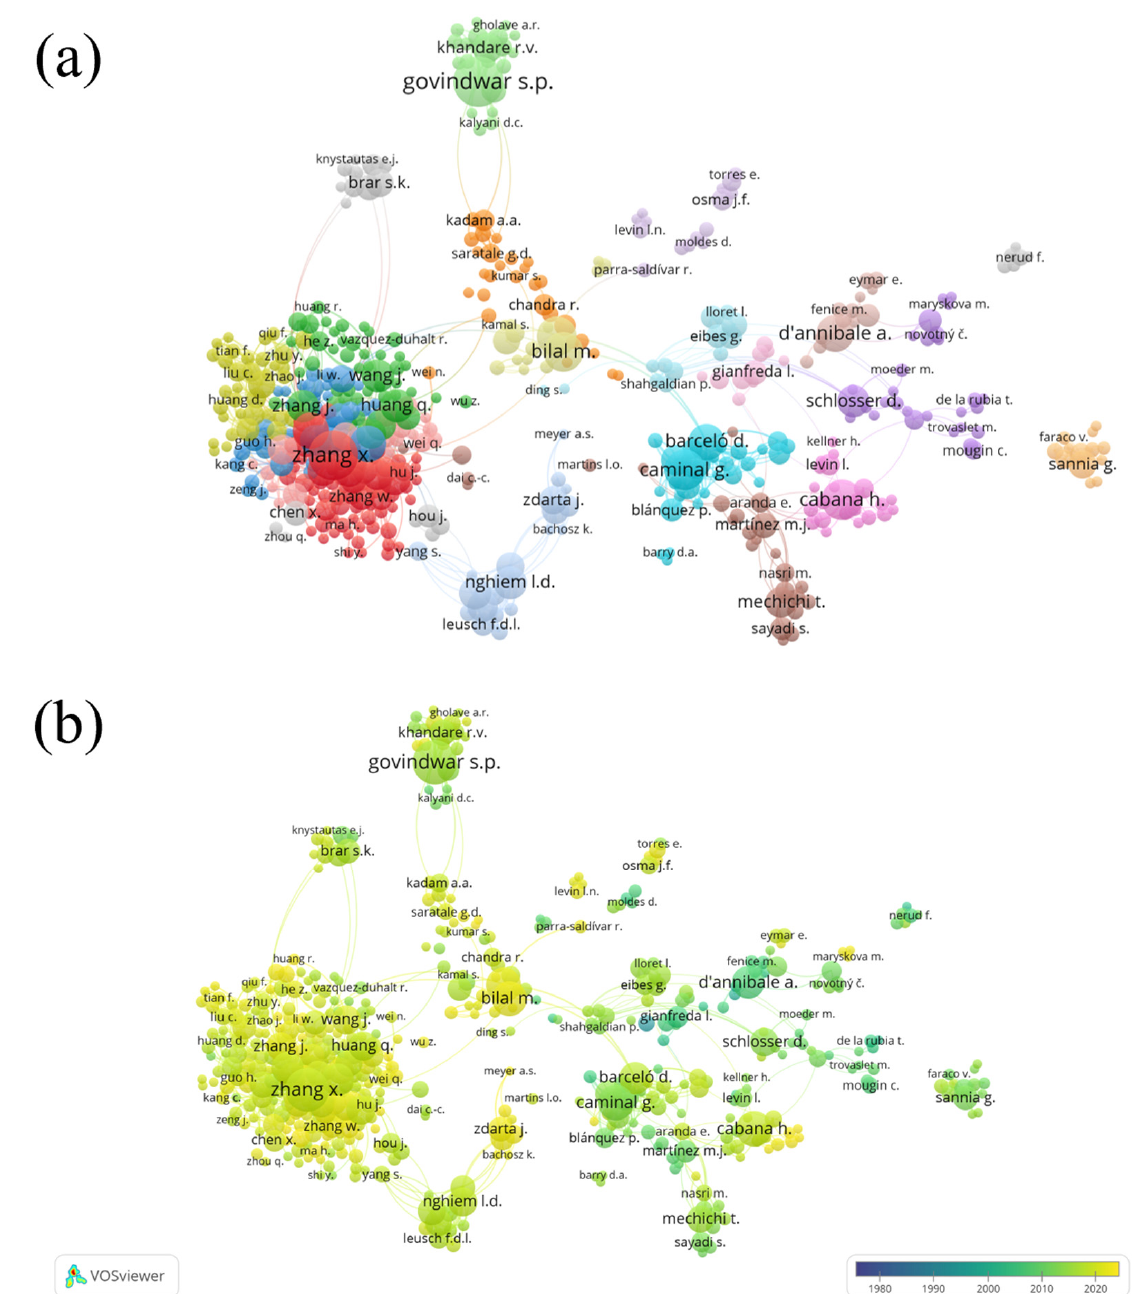
Figure 3. ( a ) Network visualization of authors’ co-authorship (weights: documents). ( b ) Overlay visualization of authors’ co-authorship in 1978–2022 (weights: documents; scores: average publications per year).